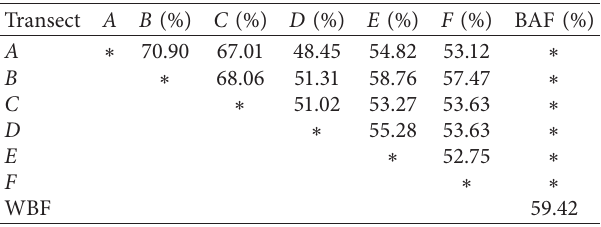
Table 2: Sorensen’s similarity index of plant species in west bank and block A forest of